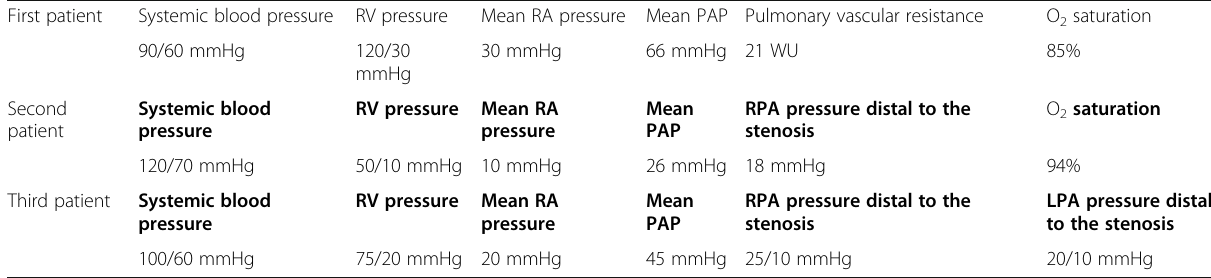
Table 1 Right heart catheterization